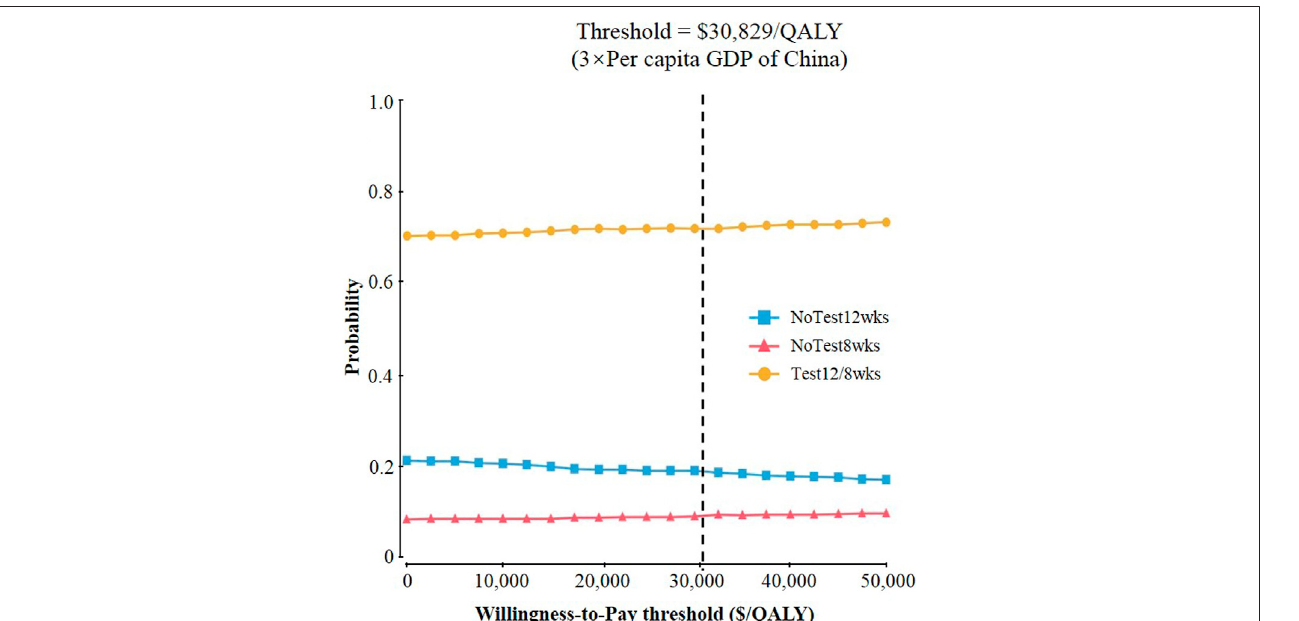
FIGURE 4 | Results of probabilistic sensitivity analyses. The cost-effectiveness acceptability curves represent probabilities of being cost-effective achieved by different competing strategies at willingness-to-pay thresholds for patients with chronic hepatitis C virus genotype 1b infection.